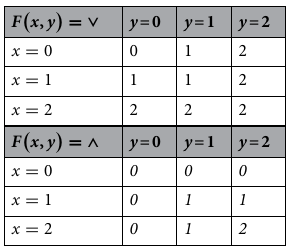
F (cid:31) x , y (cid:30) =